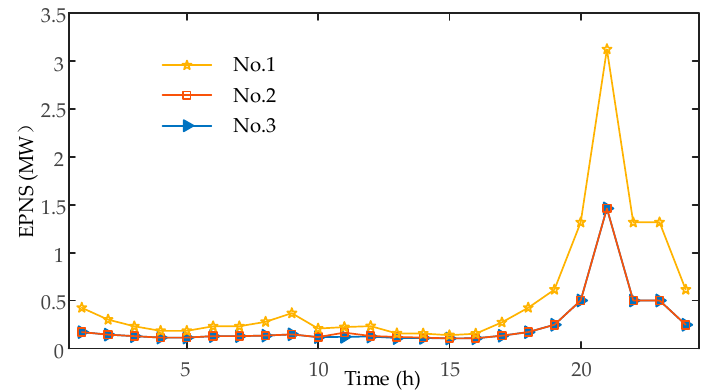
Figure 8. Curves of risk indicator expected power not served (EPNS).